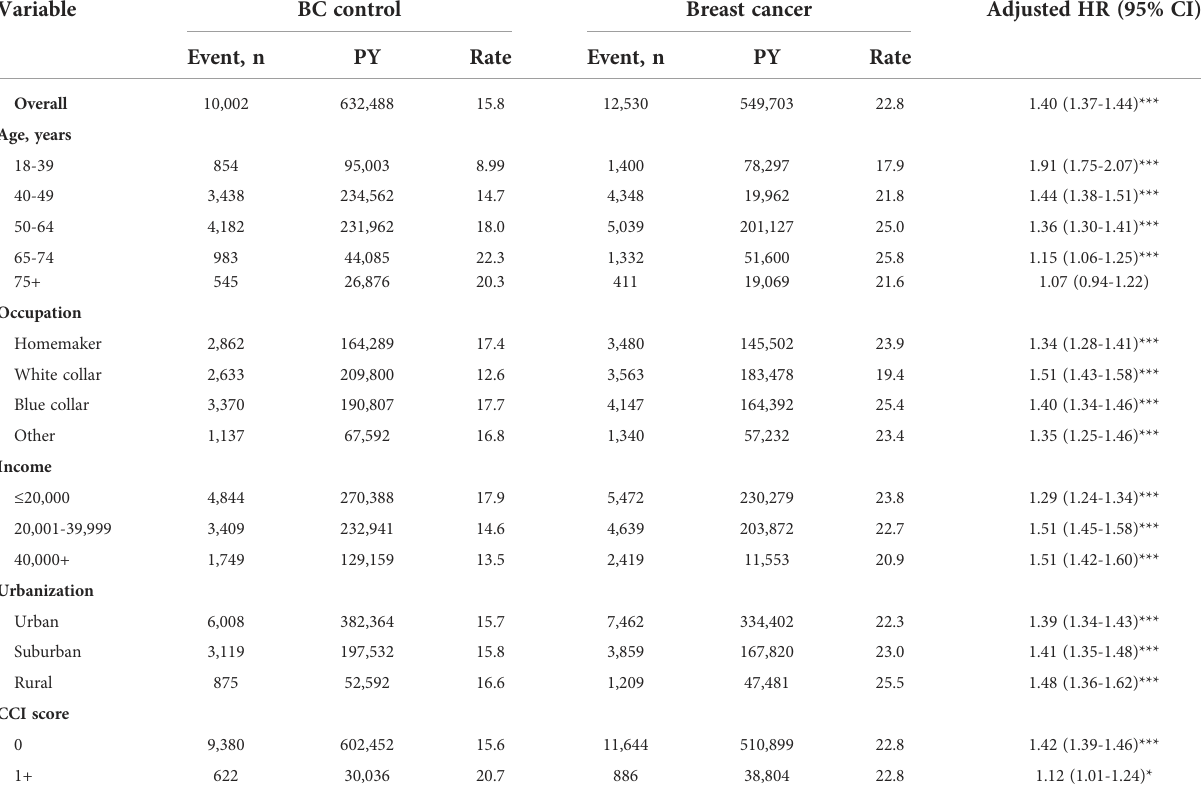
TABLE 4 Combined incidence of anxiety and depression and breast cancer cohort to comparison cohort adjusted hazard ratio by age, occupation, income, urbanization, and Charlson comorbidity index score. Variable